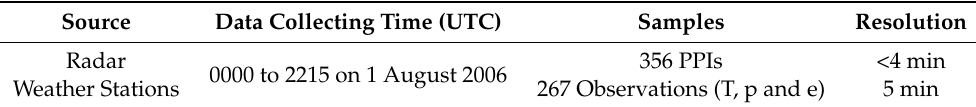
Table 3. Radar and automatic weather stations